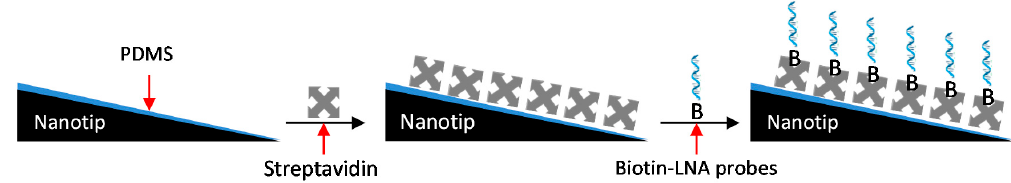
Figure 6. Surface functionalization procedure of nanotip. The nanotip is modified by immersion into a solution containing 1 mg/mL streptavidin for 2 min. The streptavidin coated nanotip is then incubated with biotinylated LNA probe for 5 min.